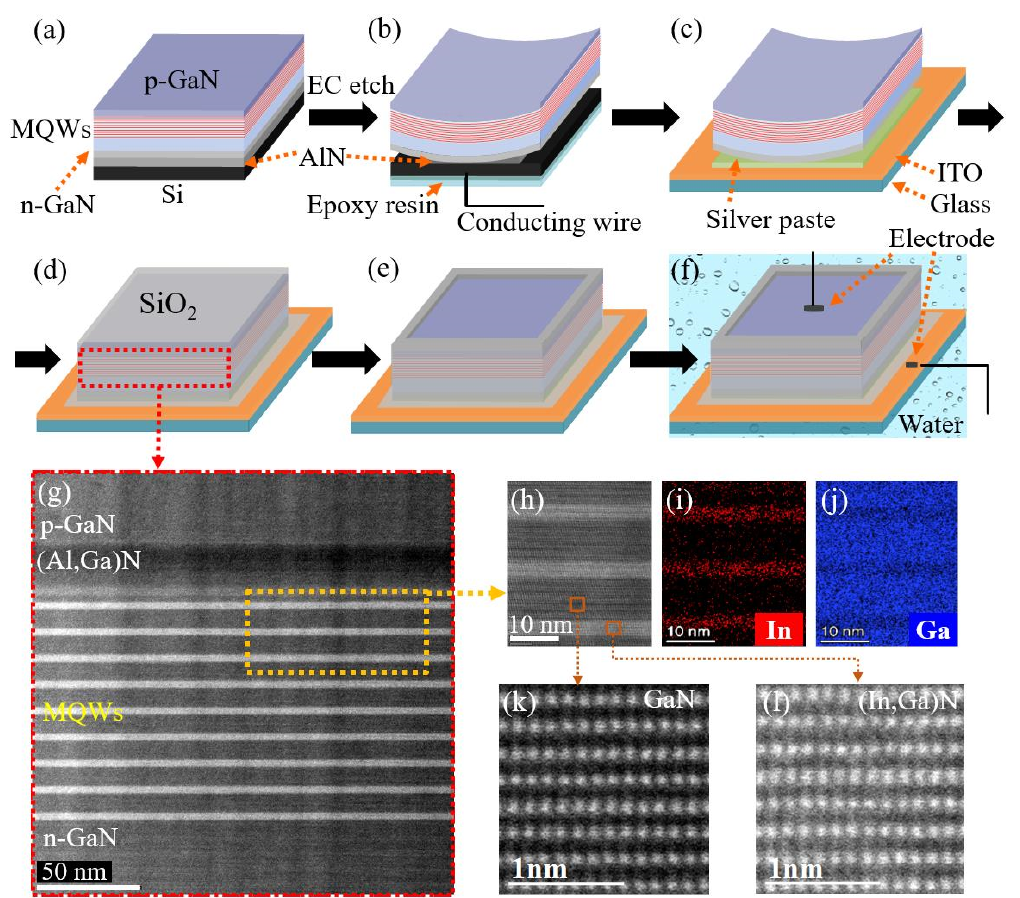
Figure 1. ( a ) Schematic diagram of the (In,Ga)N/GaN epitaxial structure on Si. ( b ) Detach the film by the EC method. ( c ) Transfer the flexible film onto the indium–tin–oxide (ITO) surface, connecting by silver paste. ( d ) Deposit the thick silica (SiO 2 ) passivation layer. ( e ) Selectively etch the SiO 2 layer. ( f ) Fabricate the metal electrodes on the GaN and ITO surfaces, then operate the device as a PEC PD under water. ( g ) Side-view STEM image of the GaN-based film after EC etching. ( h ) Enlarged scanning transmission electron microscope (STEM) image of the (In,Ga)N/GaN MQWs. High-resolution EDX mapping of the ( i ) In element and ( j ) Ga element within the (In,Ga)N/GaN MQWs. Aberration-corrected STEM (AC-STEM) images of ( k ) GaN and ( l ) (In,Ga)N crystals.